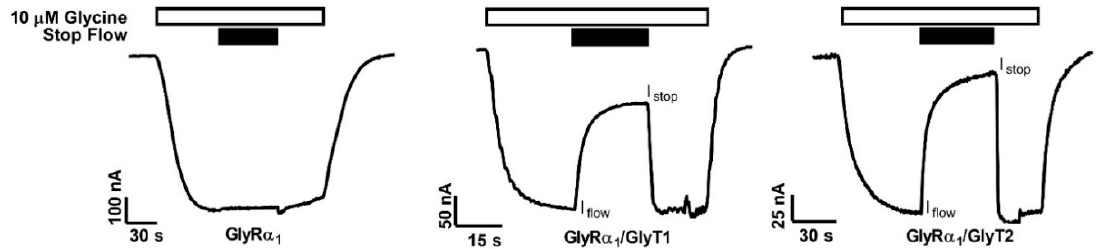
Figure 1. Reduction in glycine gated GlyR α 1 currents in oocytes co-expressed with GlyTs. GlyR α 1 is activated by 10 µM glycine (white bars). When flow of the solution is stopped on cells (black bars) expressing only GlyR α 1 there is no change in current, however stopping the flow on oocytes co-expressing GlyR α 1 with either GlyT2 or GlyT1 immediately causes a substantial decrease in GlyR α 1 current amplitude. Resumption of flow restores the full amplitude of the currents. Peak current values are also decreased in co-expressed oocytes (note scales). Table 1. Peak current reduction and stop-flow current reduction in GlyR α 1 /GlyT co-expressed cells. I stop /I flow Peak Current (nA) GlyR α 1 0.98 ± 0.01